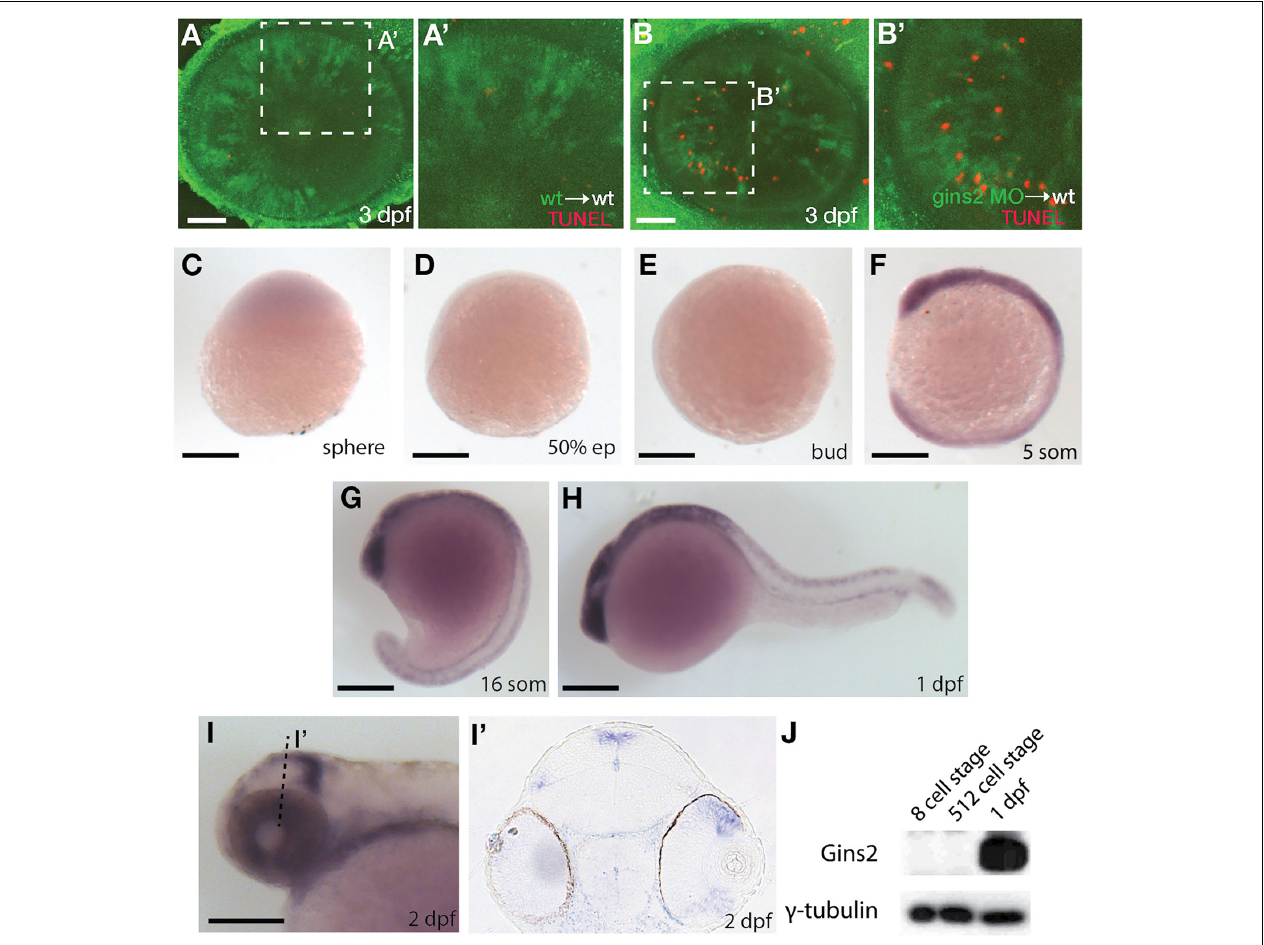
FIGURE 3 | gins2 functions cell-autonomously and is expressed in proliferating tissues. (A,B) TUNEL staining (red) of wildtype host embryos receiving heterologous cell transplants labeled with membrane-tethered GFP (green) from wildtype and gins2 MO-injected embryos. (A’,B’) show magnified views of the boxes in (A,B) . (C–I’) Lateral views (C–I) and transverse section (I’) of the wildtype embryos assessed for zygotic gins2 expression with whole mount in situ hybridization at the indicated stages. (J) Western blot analysis of protein lysates from wildtype embryos probed with Gins2 and γ -tubulin antibodies. Scale bars: (A,B) 50 µ m; (C–I) 150 µ